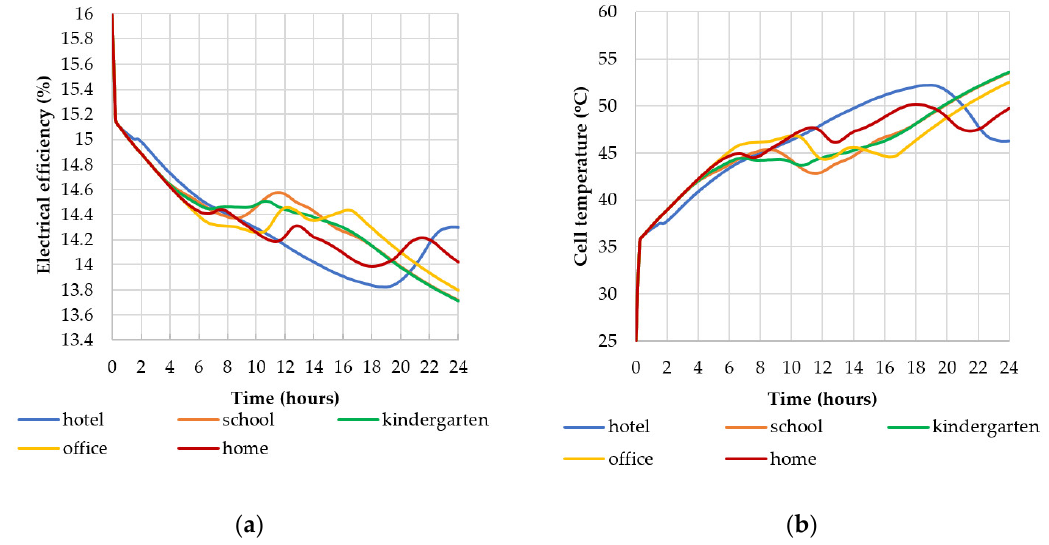
Figure 13. The variation of the ( a ) electrical efficiency; ( b ) cell temperature; as a function of the consumer demand curve.